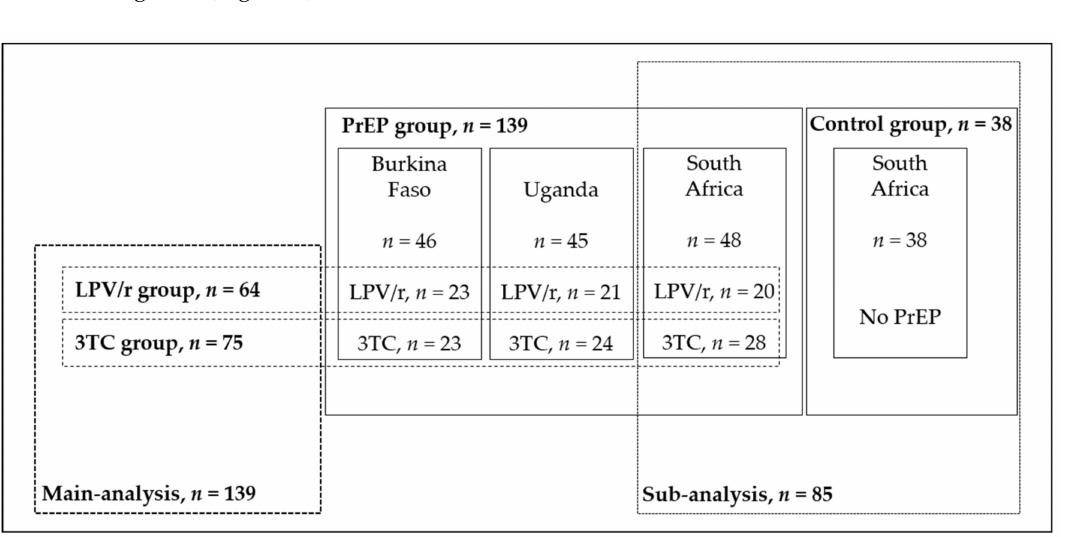
Figure 2. Details of the distribution of final populations analysed by country, group and treatment. LPV / r, lopinavir / ritonavir; 3TC, lamivudine; PrEP, pre-exposure